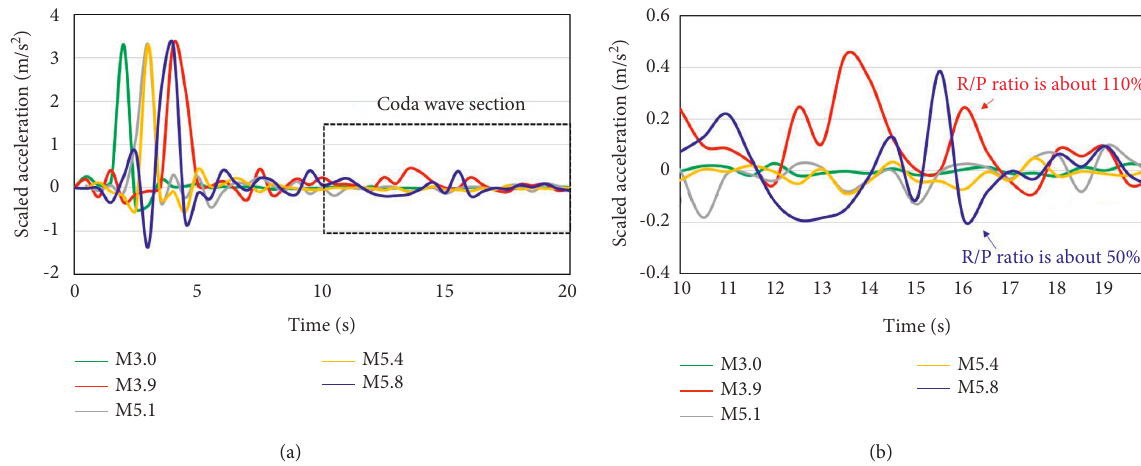
Figure 8: Comparison of the scaled acceleration of the waveforms for the five earthquakes (M3.0, M3.9, M5.1, M5.4, and M5.8). The accelerations of the M3.9 and M5.8 earthquakes are the only ones that exhibit notable amplitude fluctuations in the Coda wave section. However, the R/P ratio for the M3.9 earthquake (red line) is high, at approximately 110%, whereas the R/P ratio for the M5.8 earthquake (blue line) is low, at approximately 50%. (a) Scaled acceleration for each earthquake. (b) Scaled acceleration within the Coda wave section for each